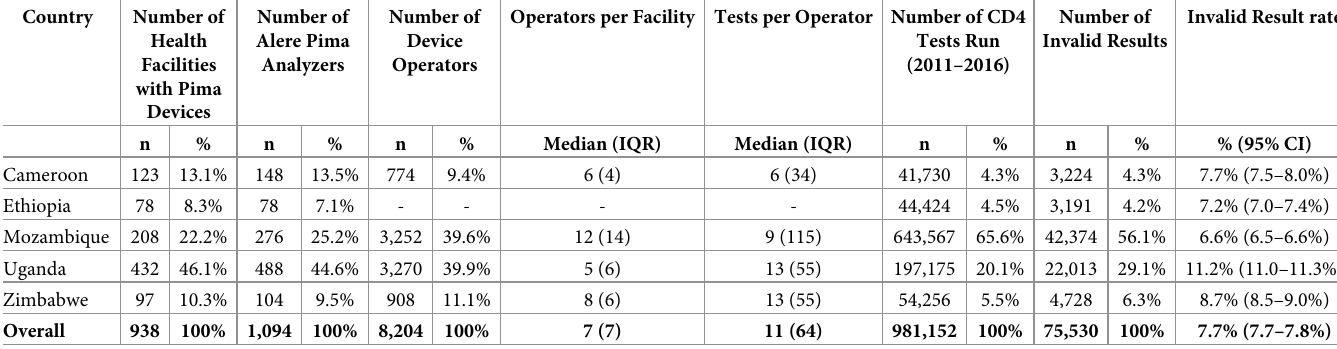
Table 1. Summary of Pima CD4 testing volumes and invalid results by country.